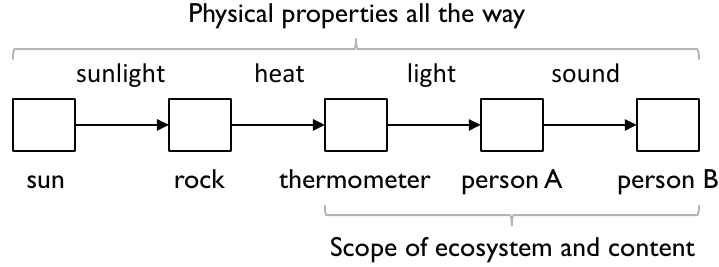
Figure 5. Physical properties and